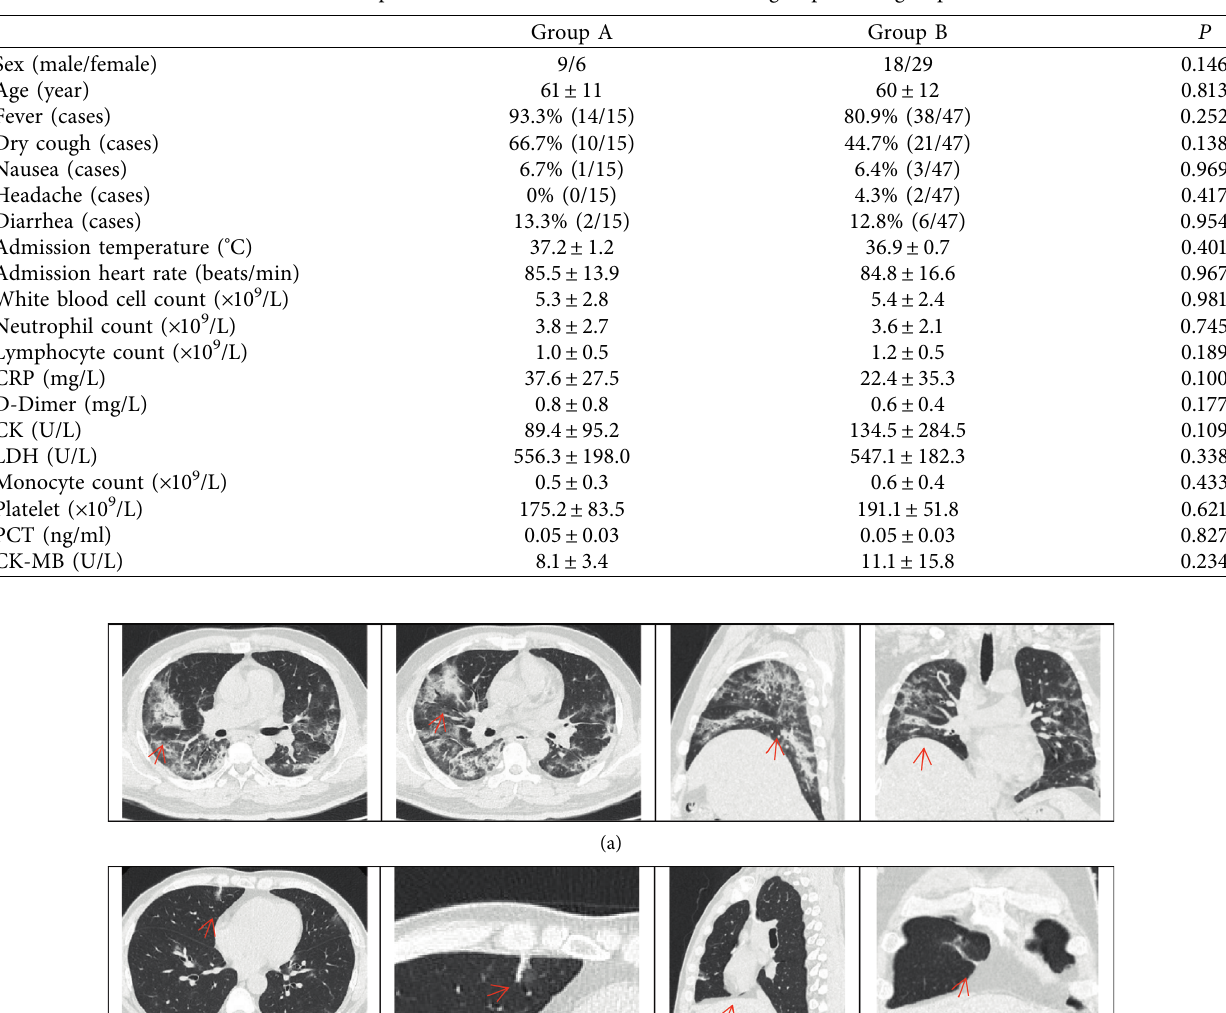
Table 1: Comparison of clinical characteristics between group A and group